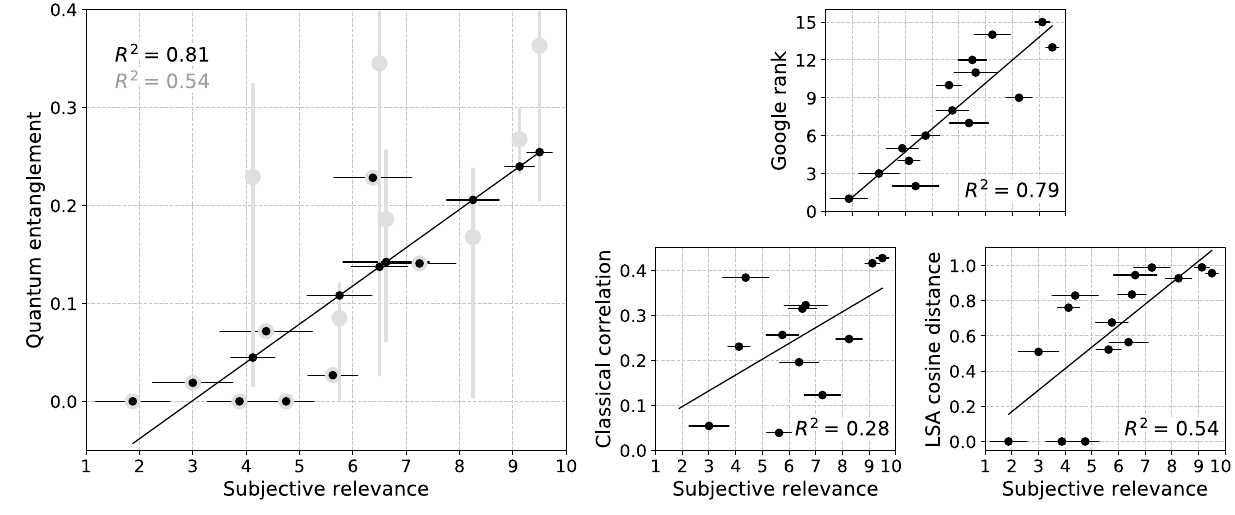
Figure 3. Left: semantic connection between concepts website and promotion quantified by concurrence entanglement measure (10) versus expert estimation of how well text answers the question << What is website promotion? >> for 15 probe documents. Gray bars show range of concurrence values accessible by tuning of quantum phases φ ij in perception model of each document. Compared to the phase-randomized concurrence 2 (gray circles), phase-tuned values (black dots) increase R from 0.54 to 0.81. Top right: ranking of the probe documents by Google search for the query website promotion . Bottom right: classical correlation 2 (11) and the LSA cosine distance between the same concepts (Methods). R are determination coefficients. Horizontal axis, data and statistical error bars are common for all panels except three documents for which classical correlation is undefined. All data are given in Table 2.